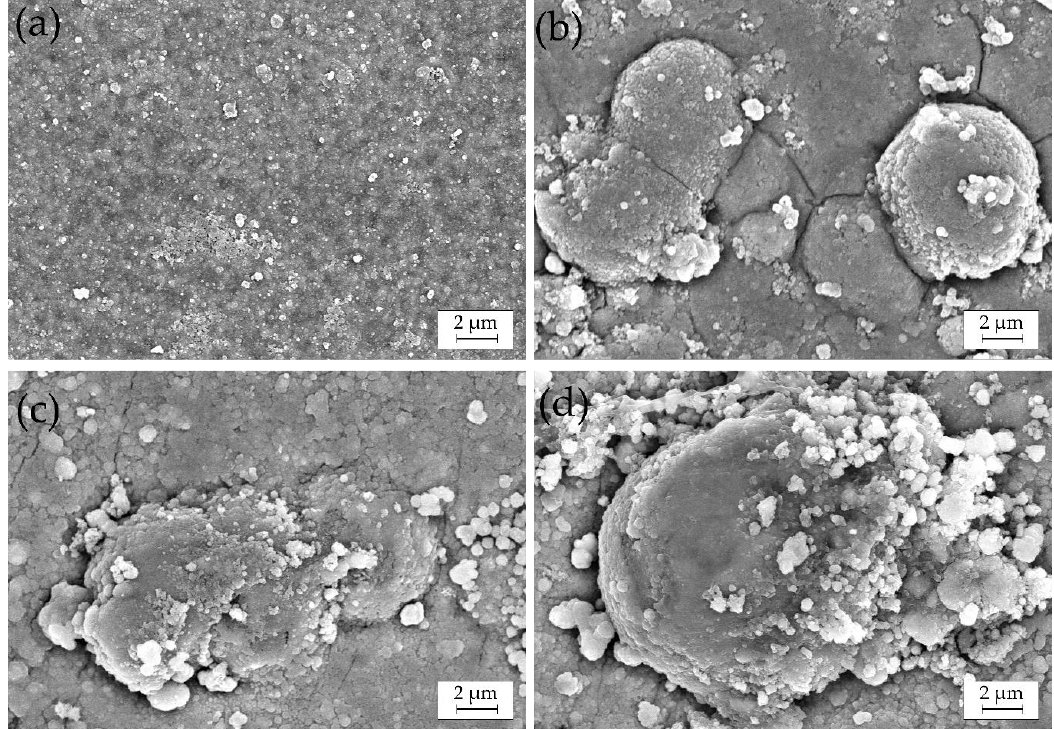
Figure 12. SEM images of Ti-0 ( a ), Ti-1( b ), Ti-5 ( c ), and Ti-10 ( d ) after 168 h of corrosion experiment in 3% NaCl solution.